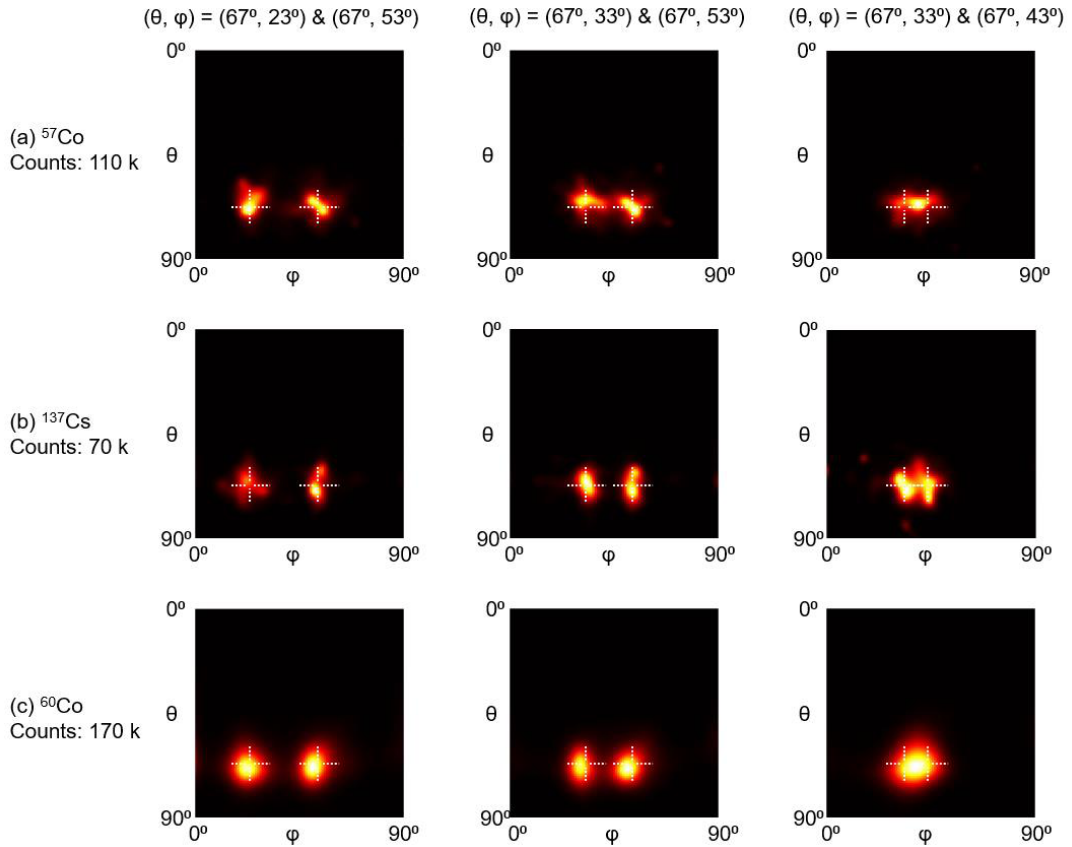
Figure 13. Reconstruction images of two ( a ) 57 Co, ( b ) 137 Cs, and ( c ) 60 Co point sources at different distances.